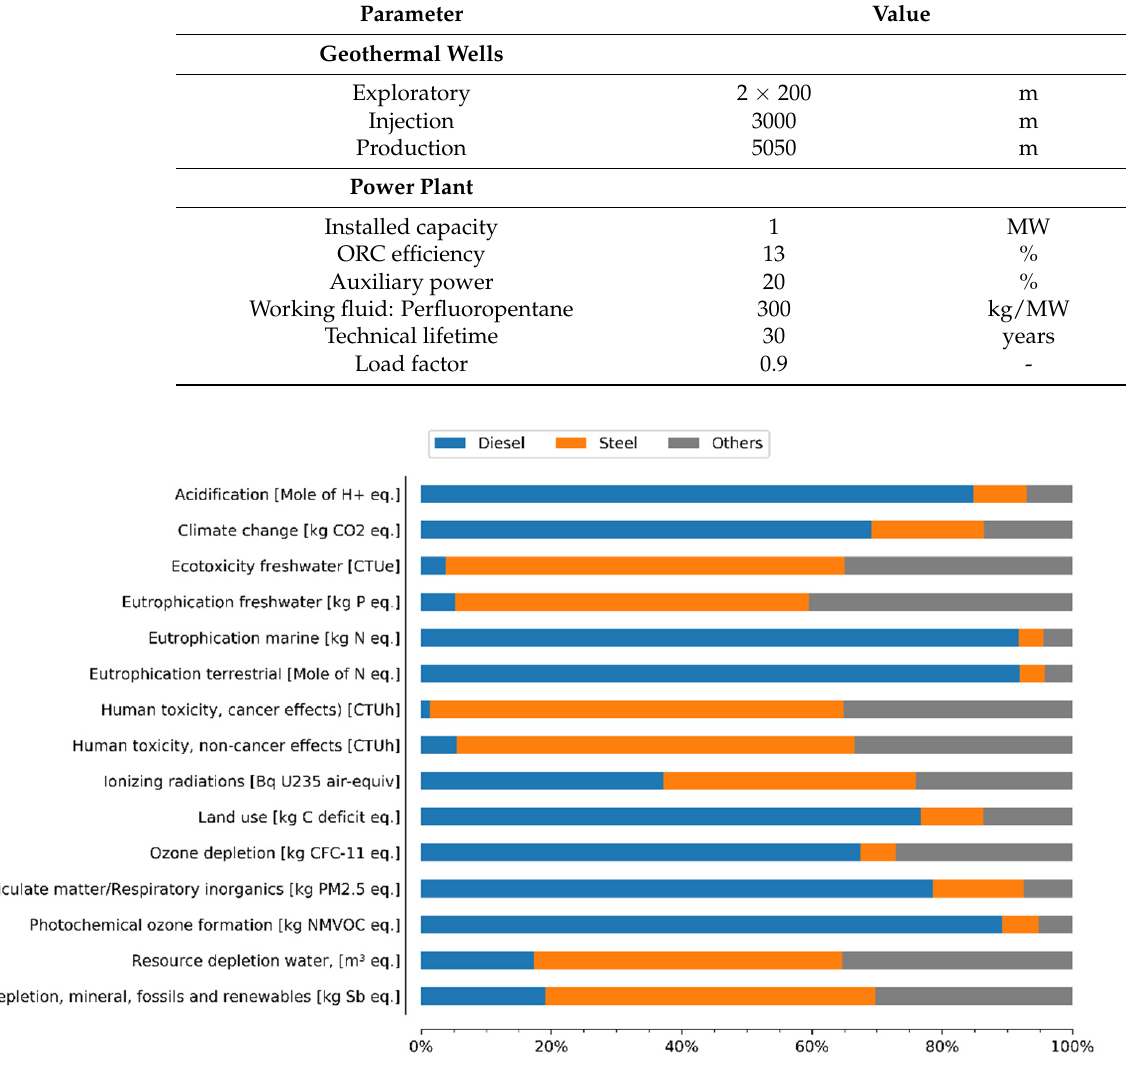
Figure 7. Hot-spot analysis on UDDGP, based on data from [23].